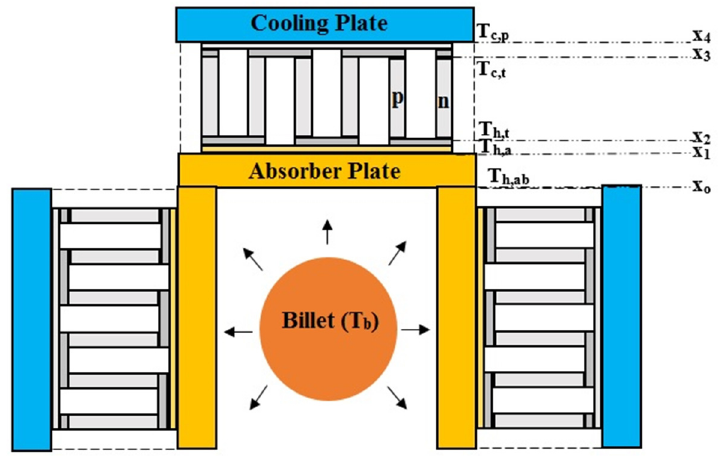
Figure 6. Temperature distribution at various locations across a TEG in numerical